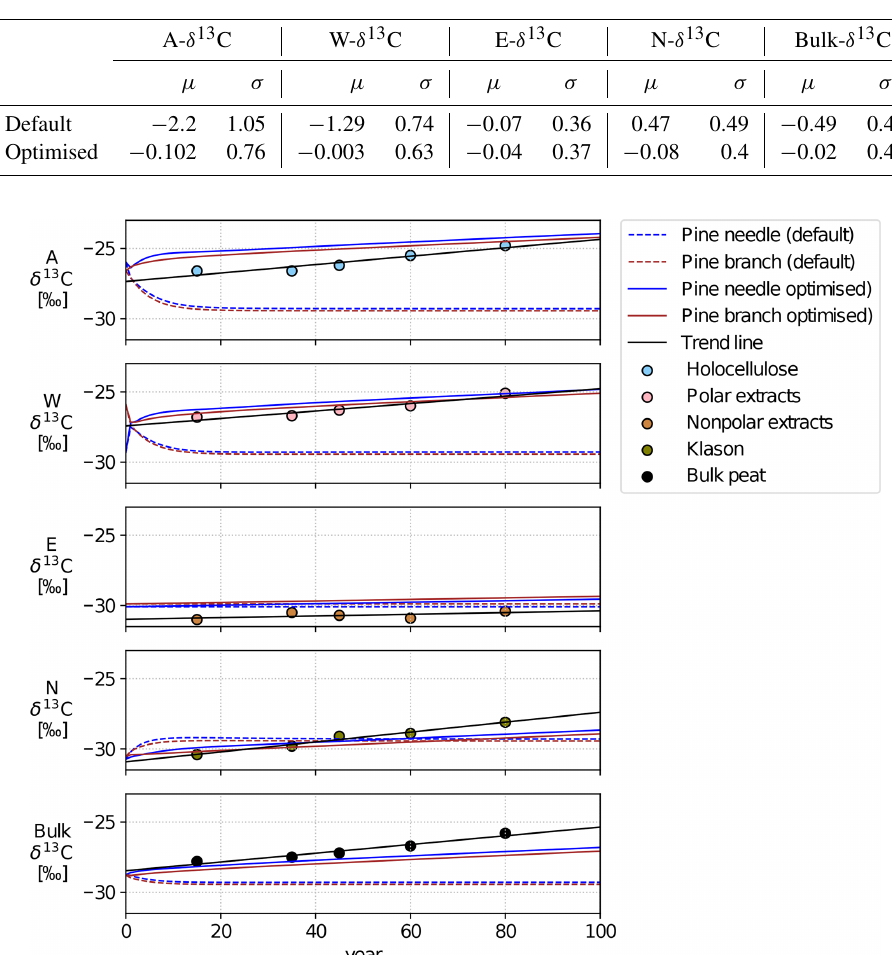
Figure 3. Time series of simulated δ 13 C values of the different AWEN pools for the default and optimised Yasso model versions. Scatterplot shows the peat column δ 13 C values at different depths, positioned at the midpoint of assumed age, along with corresponding trend